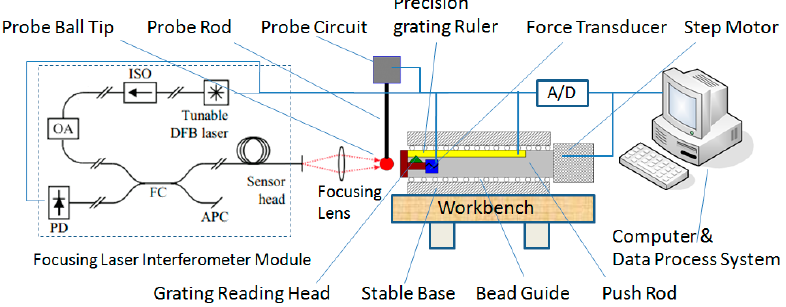
Figure 3. A schematic diagram of the probe parameter calibration system.